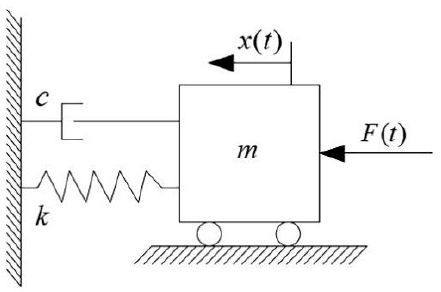
Figure 6. Linear motor mechanical loading model.